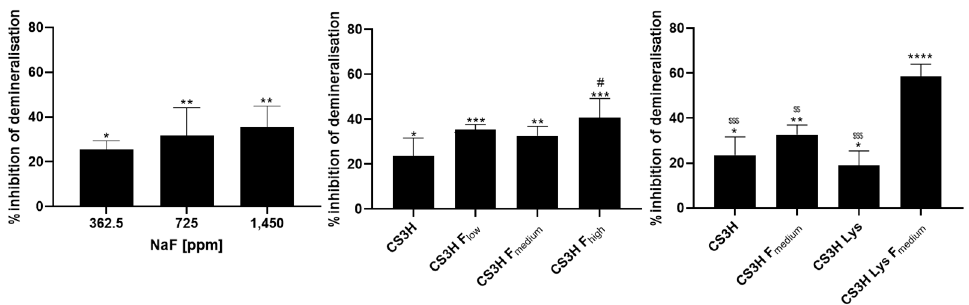
Figure 3. Inhibition of phosphate release by NaF, chitosan, and its derivatives. Data are reported as mean ± SD, n = 3. Data were analyzed by one-way ANOVA followed by Tukey’s multiple comparisons (* p < 0.05, ** p < 0.01, *** p < 0.001 and **** p < 0.0001 compared to deionized water; # p < 0.05, compared to CS3H; $$ p < 0.01, $$$ p < 0.001 compared to CSH3 Lys F medium ).